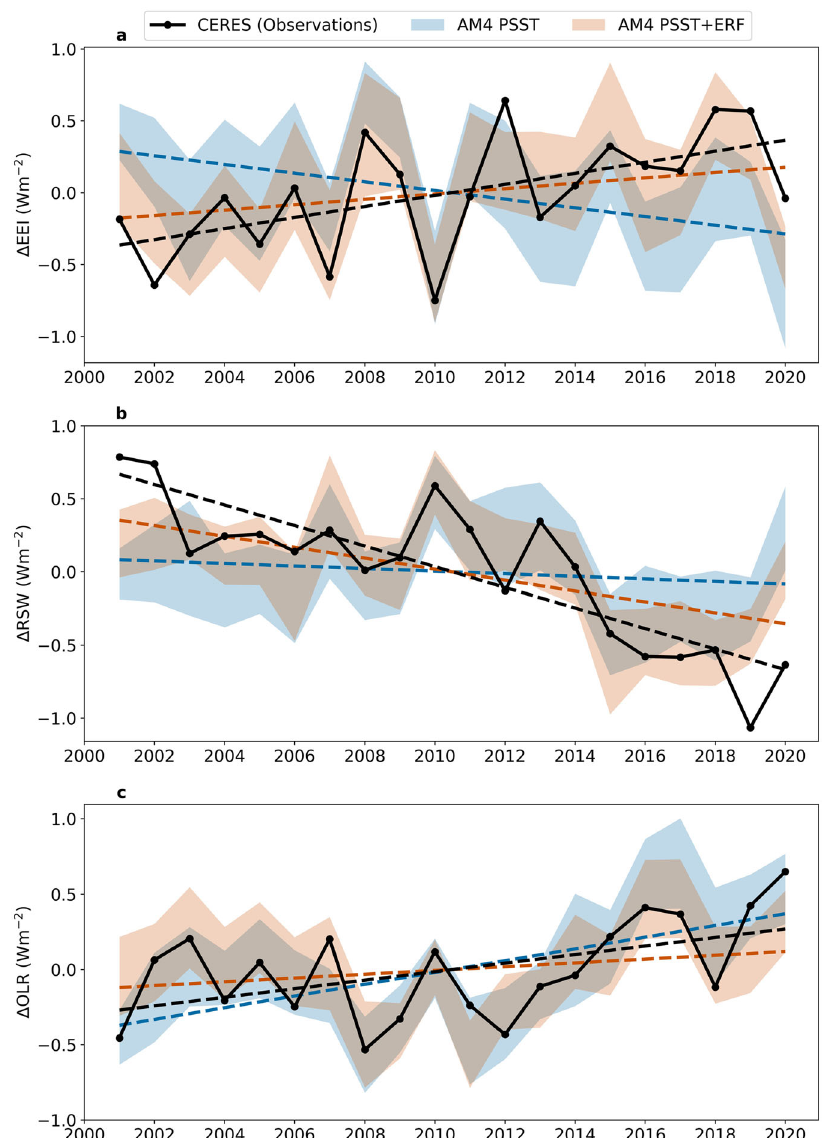
Fig. 1 Global-mean Earth ’ s radiation budget time series. Interannual anomalies (denoted by Δ ) in a , Earth ’ s Energy Imbalance (EEI), b , re fl ected shortwave radiation (RSW), c , outgoing longwave radiation (OLR) during 2001 – 2020. Blue and orange shading each represent the full range of twenty- time series realizations in each ensemble. Positive (negative) values indicate more energy in the Earth system for EEI (RSW and OLR). Blue and orange dashed lines represent ensemble mean trends. CERES = Clouds and the Earth ’ s Radiant Energy System satellite observations (black), AM4 PSST = Prescribed Sea Surface Temperatures (SSTs) and sea ice with forcing agents held fi xed at 2014 levels in Geophysical Fluid Dynamics Laboratory Atmosphere Model 4 (AM4) (blue), and AM4 PSST + ERF = same as AM4 PSST but with effective radiative forcing changes (ERF; forcing agents varying)